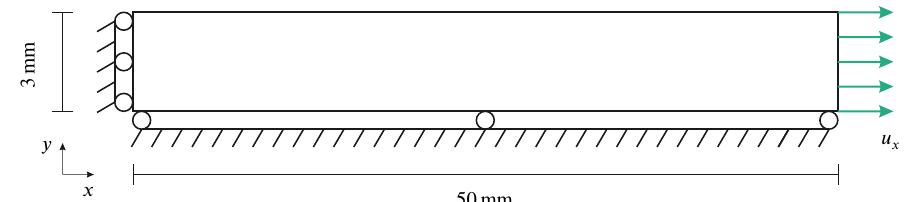
Figure 8. Two-dimensional numerical FIGURE 8 Two-dimensional numerical model.